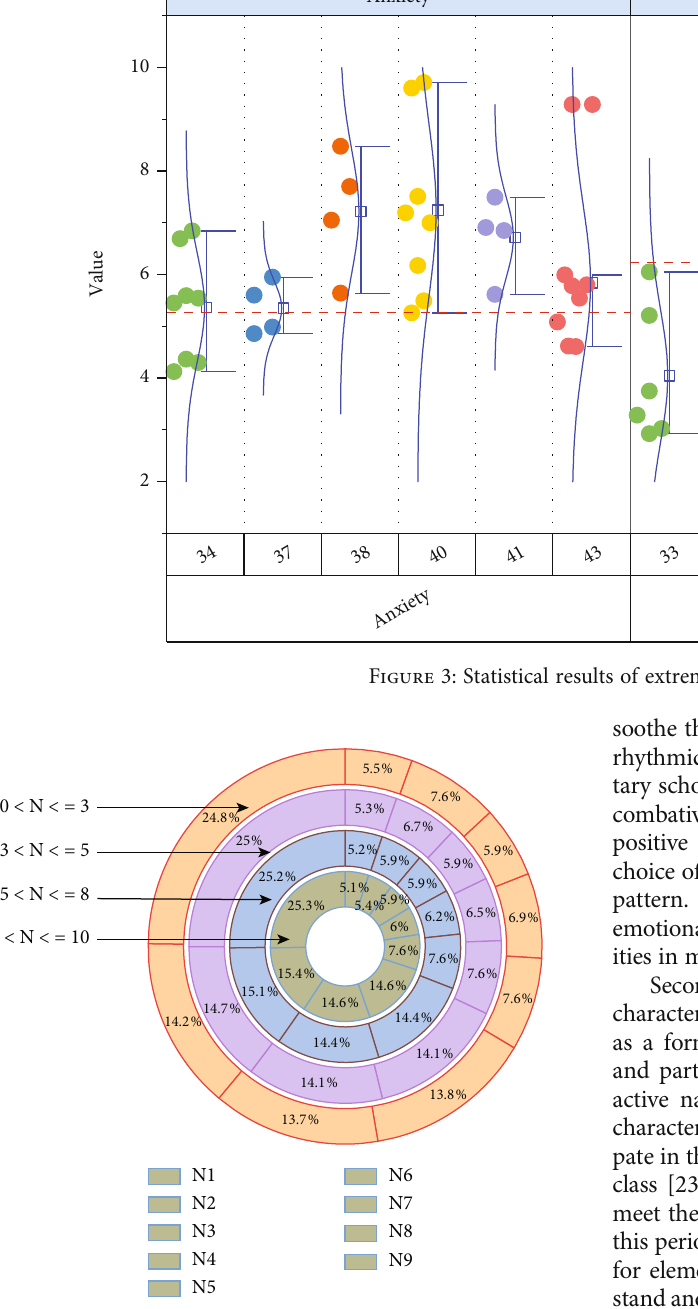
Figure 4: Main composition of the primary and secondary school